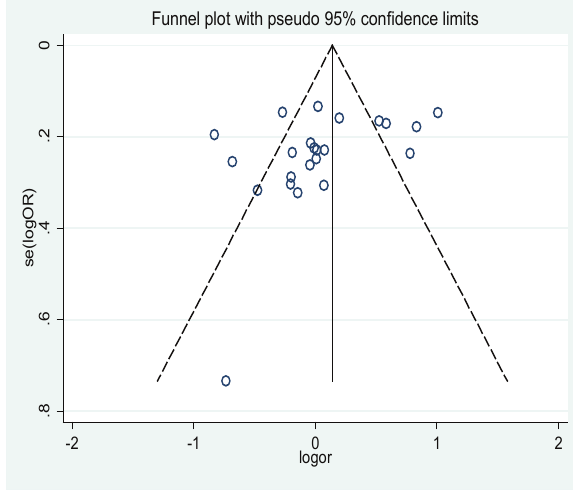
Figure 2: The Begg’s funnel plots showe no significant publication bias under dominant model (GG+AG vs AA)..